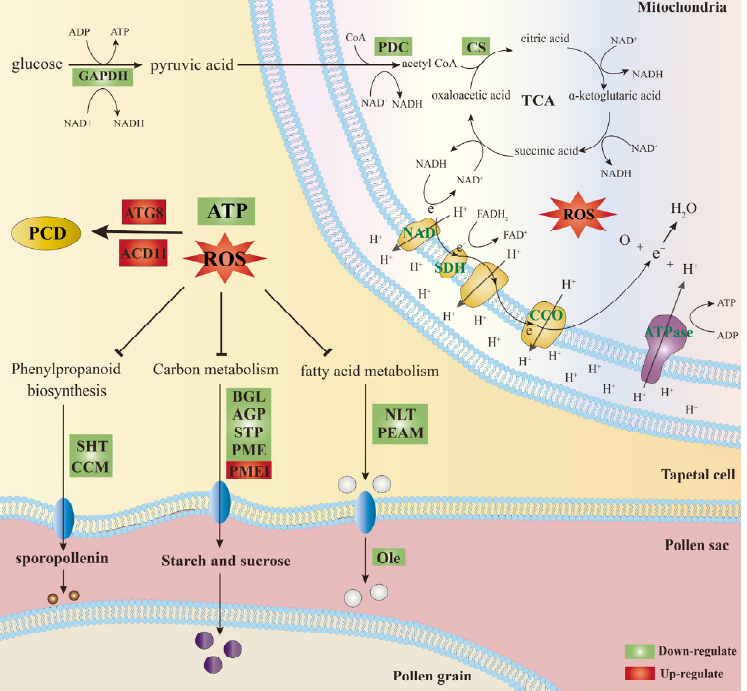
Figure 7. Potential transcriptome-mediated regulation network in cabbage Ogura CMS. PCD, programmed cell death; GAPDH, glyceraldehyde-3-phosphate dehydrogenase; PDC, pyruvate dehydrogenase; CS, citrate synthase; ND, NADH dehydrogenase; SDH, succinate dehydrogenase; CCO, cytochrome c oxidase; ATG8, autophagy-related protein 8; ACD11, accelerated cell death 11; SHT, spermidine hydroxycinnamoyl transferase; CCM, ca ff eoyl-CoA O-methyltransferase; BGL, Beta- glucosidase; AGP, arabinogalactan protein; STP, sugar transport protein; PME, pectinesterase; PMEI, Pectinesterase inhibitor; NLT, non-speci fi c lipid-transfer protein; PEAM, phosphoethanolamine N- methyltransferase; Ole, Oleosin. 4. Materials and Methods 4.1. Plant Materials The plant materials used in this study were created and provided by the Institute of Vegetables and Flowers, Chinese Academy of Agricultural Sciences (IVF-CAAS). 19–616 is a normal fertile cabbage material, 19–2167 is an Ogura CMS material containing the sterility gene orf138 , and FR2202 is a restorer line containing both the sterility gene orf138 and the restoration gene Rfo . The lines had the same genetic background and were created through multigeneration backcrossing. The three materials were planted in the experi- mental base of IVF-CAAS in autumn 2019 and transplanted to the cold frame for vernali- zation in winter. In April of the following year, fl ower buds at the tetrad stage (2–3 mm) were collected, quickly frozen in liquid nitrogen, and then stored in a − 80 °C freezer for transcriptome sequencing and fl uorescence quantitative expression analysis [44]. 4.2. Observation of Pollen Viability The pollen viability of the three materials was observed by Alexander staining. At the full fl owering stage, the newly opened fl owers of the same day were removed, the petals and stamens were removed, the pollen was spread on a slide, and 2–3 drops of Alexander staining solution were added and mixed thoroughly. The slide was covered immediately, and the pollen was dyed for 3–6 h. Finally, the slides were observed under the microscope immediately after absorbing the excess liquid [67]. 4.3. Library Construction and ONT Sequencing